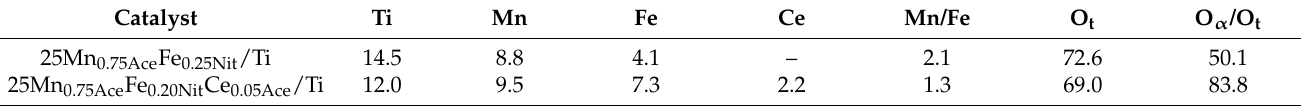
Table 3. Atomic% of MnFe/Ti and MnFeCe/Ti catalysts determined by XPS (X-ray photoelectron spectroscopy). Catalyst Ti Mn Fe Ce Mn/Fe O t O α /O t 25Mn 0.75Ace Fe 0.25Nit